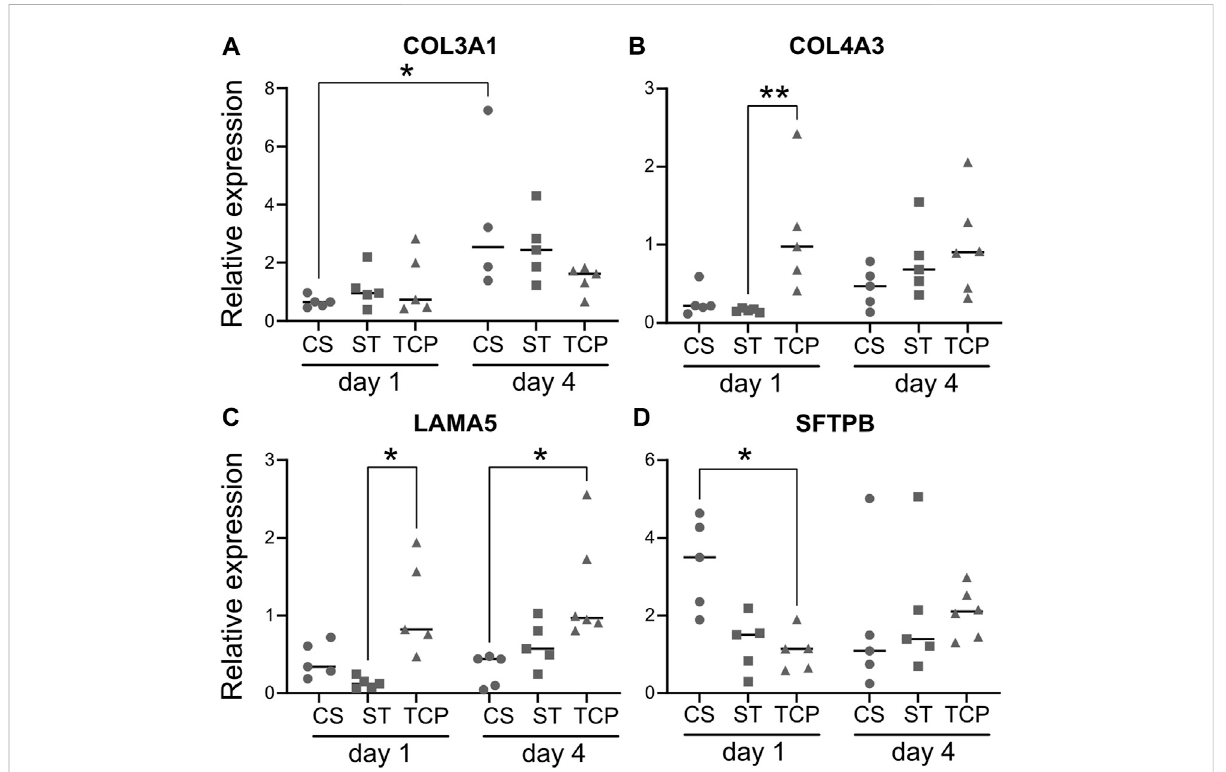
FIGURE 5 Quantitative PCR analysis of the expression of ECM and surfactant genes. Gene expression results for collagen type III α 1 chain (COL3A1, (A) , collagen type IV α 3 chain (COL4A3, (B) , laminin α 5 (LAMA5, (C) and surfactant protein B (SFTPB, (D) for the H441 epithelial cells cultured in the different conditions tested. Data is presented as relative expression compared to TCP at day 1, with individual points (biological replicates or “ n ” ) togetherwiththemedian.CS:cyclicstretch(circles),ST:staticculture(squares),TCP:tissuecultureplastic(triangles),*: p < 0.05. n =5forevery gene for CS and ST, except for CS at day 4 for COL3A1 ( n = 4). n = 3 for TCP in every